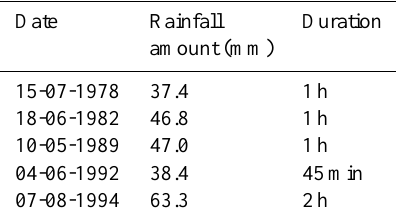
Table 2. Characteristics of historical rainstorms producing debris flows in the Sanyanyu